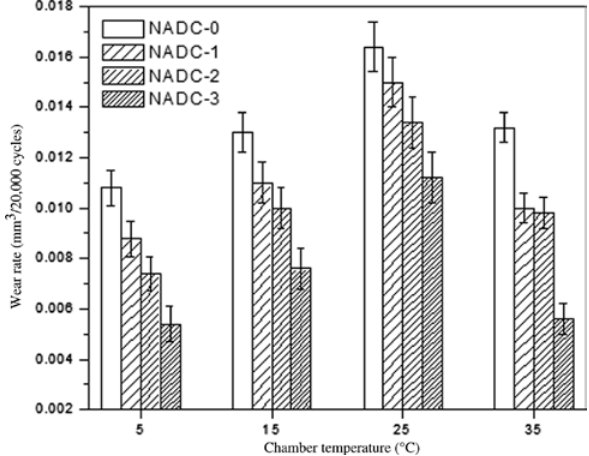
Figure 8: Effect of chamber temperature on volumetric wear rate of the dental composites in distilled water condition (at constant normal load of 40 N and chewing speed of 5